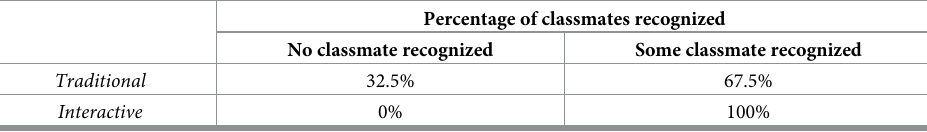
Table 3. Percentage of students’ names participants recognized across the two